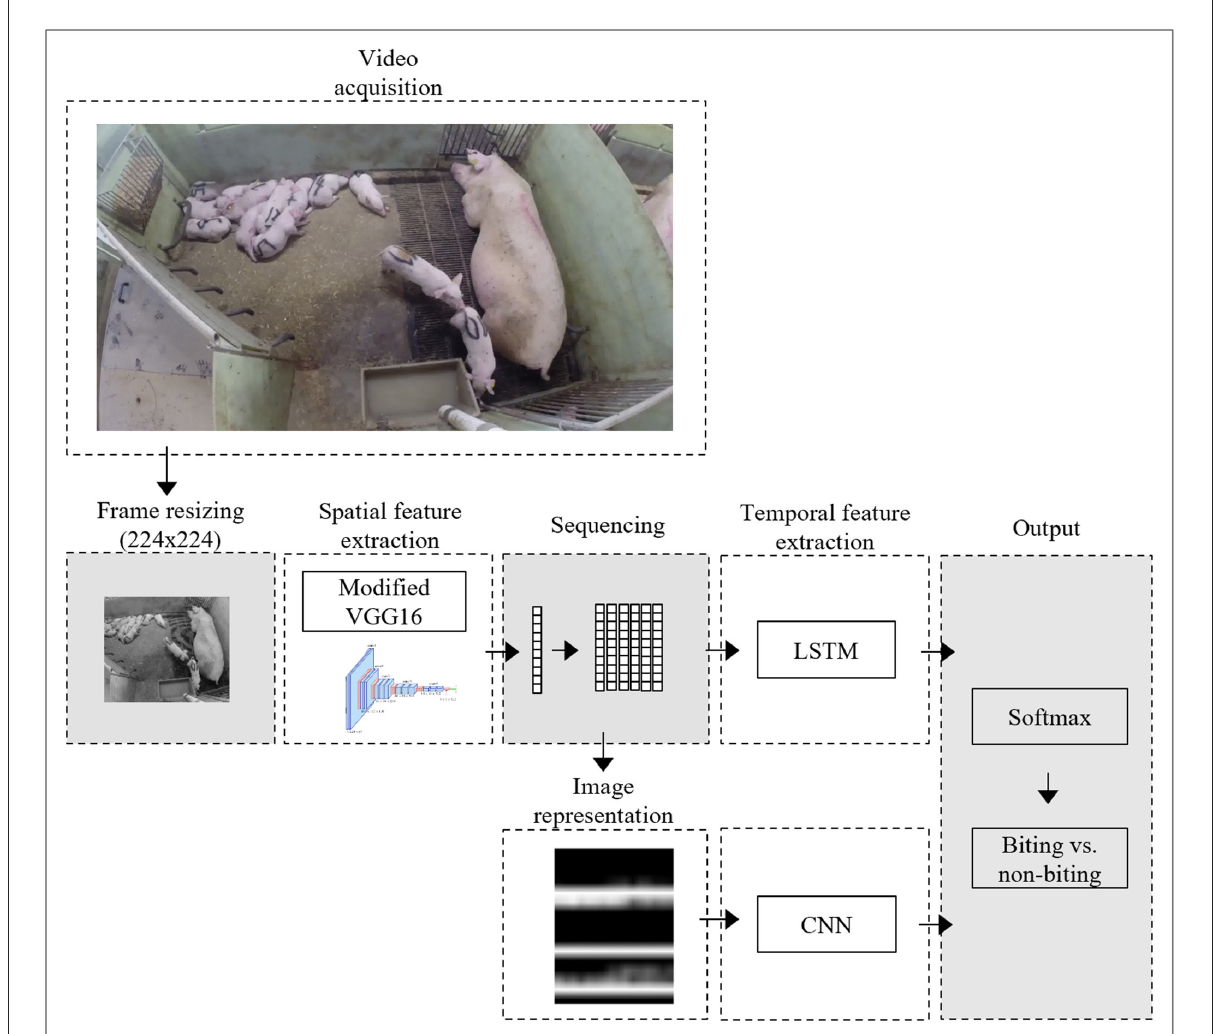
FIGURE1 Schematic illustration of the processing approach, showing the steps from video acquisition to output generation for the CNN-LSTM and CNN-CNN networks.